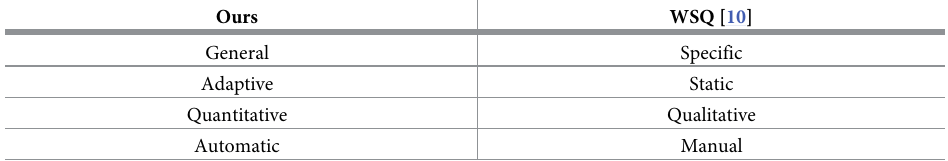
Table 1. Comparing our method with questionnaire-based stress level detection